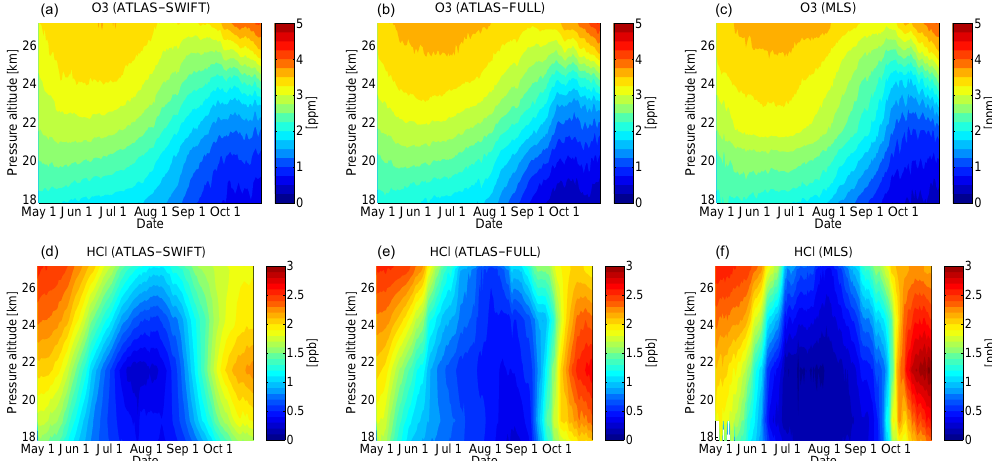
Figure 18. Same as Fig. 17 for the southern hemispheric winter